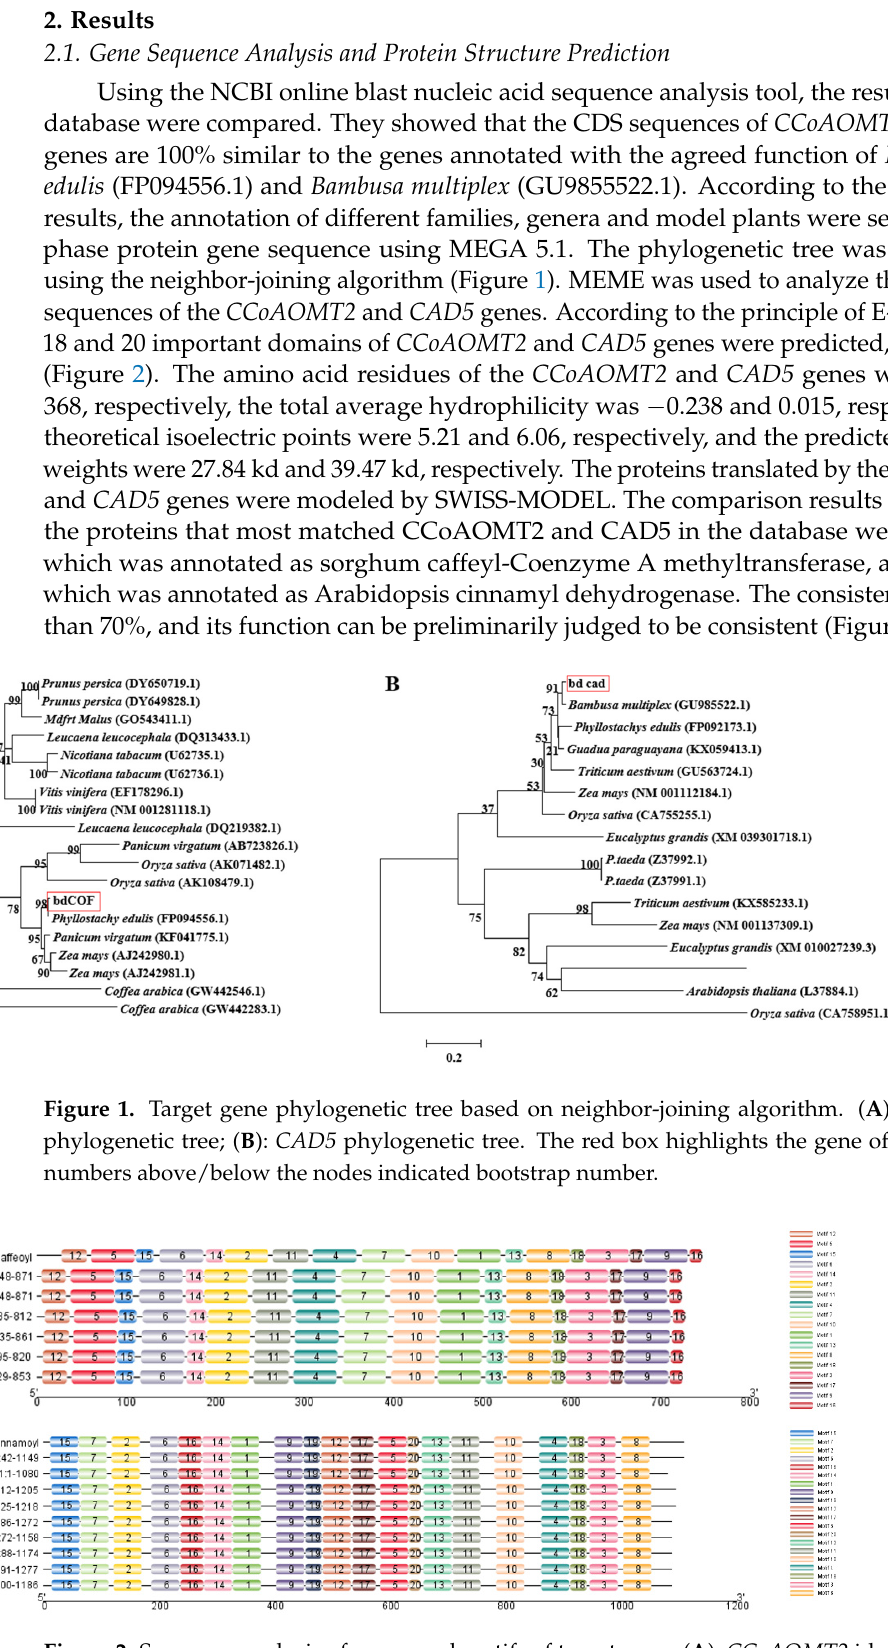
Figure 2. Sequence analysis of conserved motifs of target gene. ( A ): CCoAOMT2 identified 18 con- servative motifs, different motifs are distinguished by different color numbers; ( B ): CAD5 identified 20 conservative motifs, different motifs are identified by different color numbers.